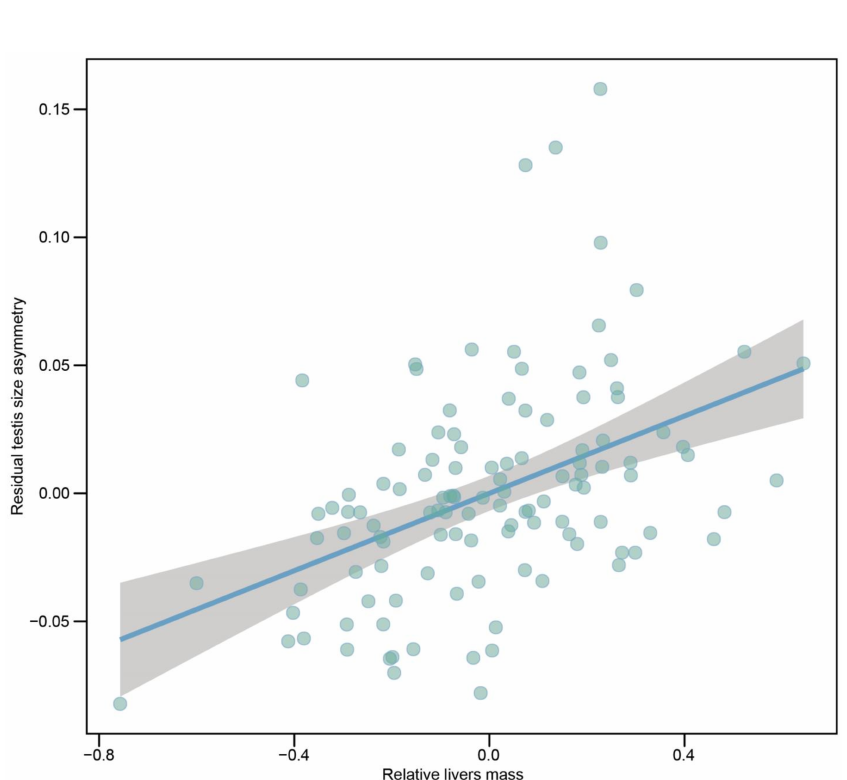
Figure 4. Partial regression plot of residual testes size asymmetry on residual livers mass when controlling for effects of combined testes mass, SVL and phylogeny across 116 species of anurans. SVL, combined testes mass and livers mass were log 10